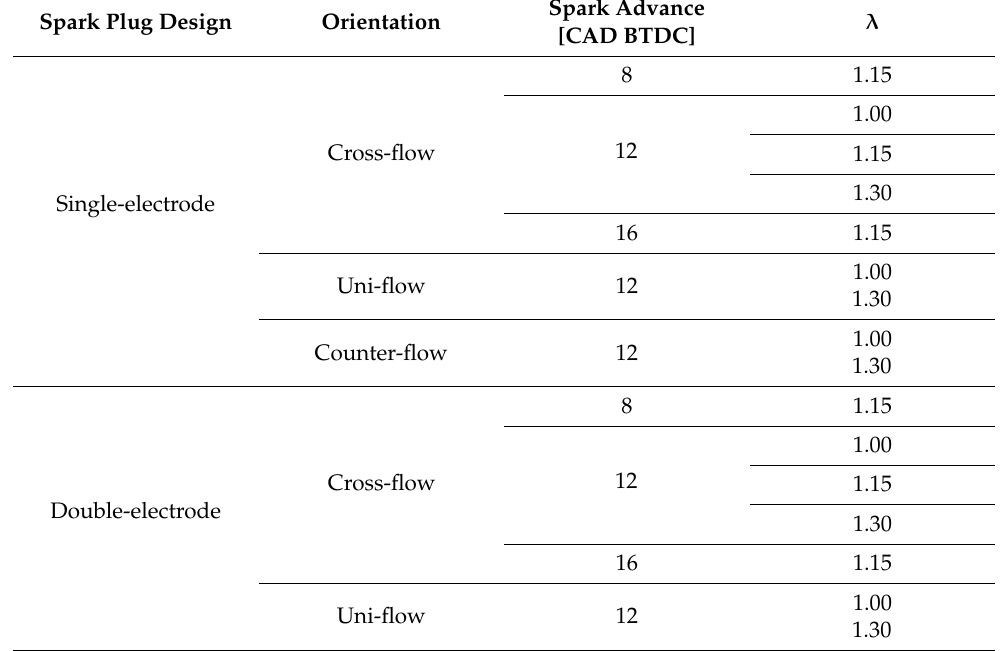
Table 2. Operating